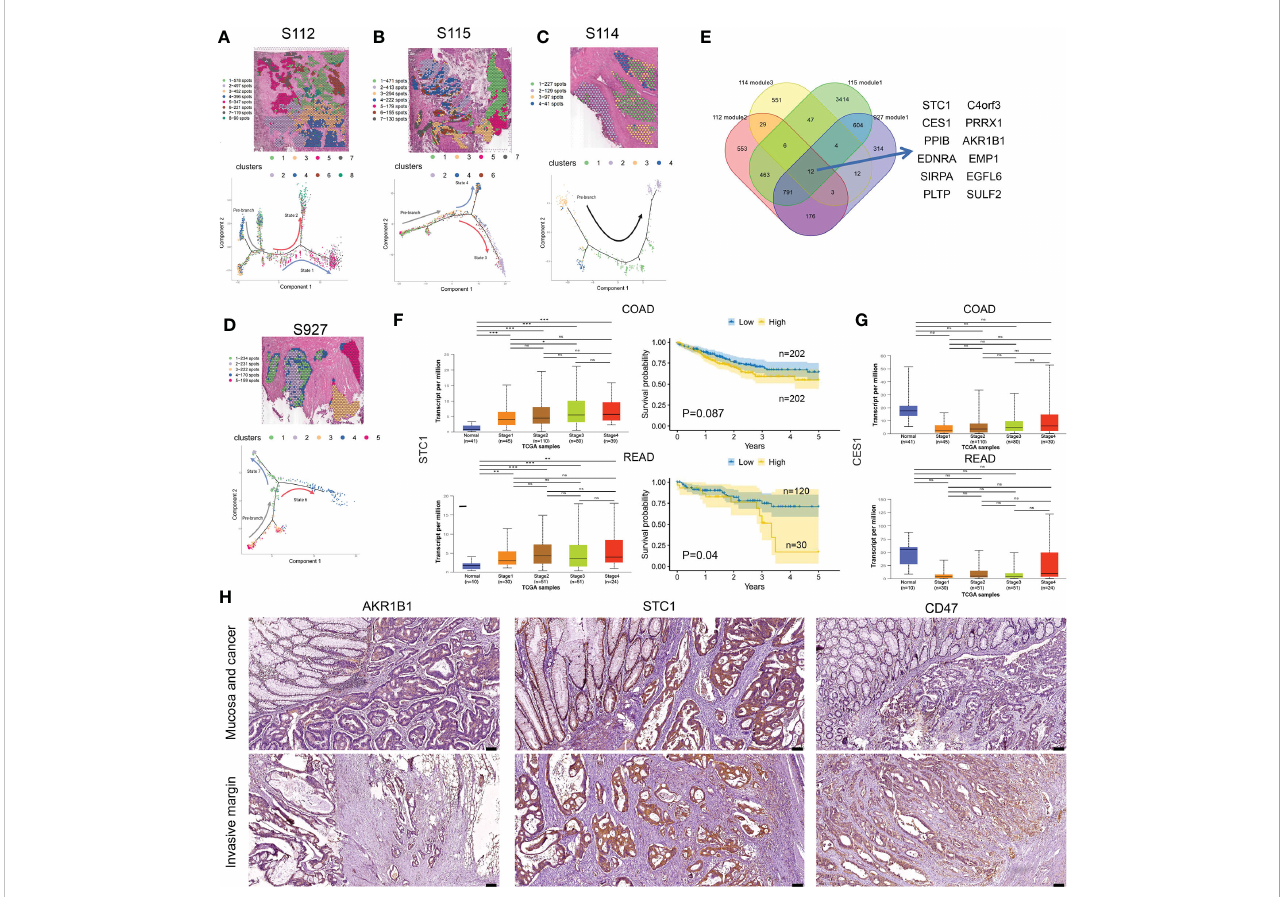
FIGURE 5 Cell differentiation trajectories in CRC obtained by pseudotime analysis. (A – D) tSNE map shows the results of the dimensionality reduction and clustering analysis of S112 (A) , S115 (B) , S114 (C) , and 927 (D) (up). Results of pseudotime cell trajectory in S112 (A) , S115 (B) , S114 (C) , and S927 (D) (down). (E) Twelve genes were screened by invasive modules. (F) The relationship of STC1 expression level and cancer stage/progression-free survival in colon cancer (up) and rectal cancer (down) from TCGA database. (G) The relationship of CES1 expression level and cancer stage in colon cancer (up) and rectal cancer (down) from TCGA database. (H) Immunohistochemical staining showed the expression of AKR1B1(left panel), STC1(middle panel), and CD47(right panel) in Mucosa and cancer(up) and Invasive margin(down) (n=45). The scale bars on the lower right are 100 µm. *P < 0.05, **P < 0.01 and ***P < 0.001. NS, not signi fi cant